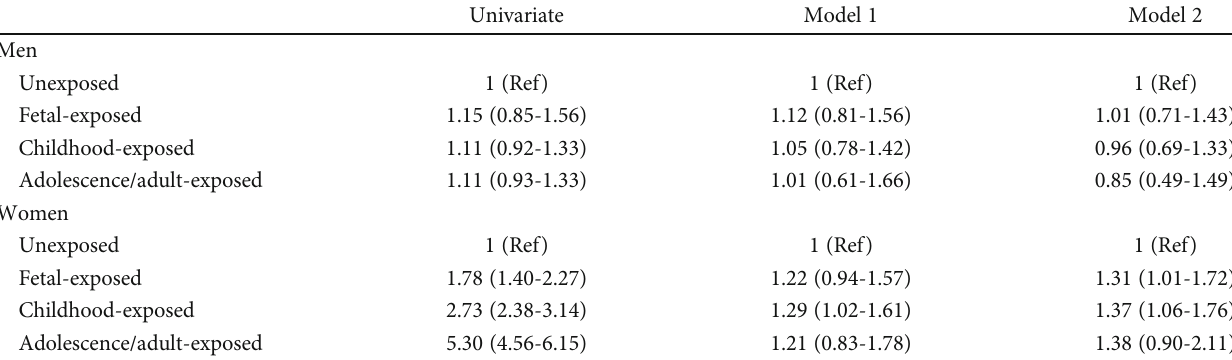
Table 6: Odds ratio (95% con fi dence interval) of metabolic syndrome in relation to di ff erent life stages at famine exposure by the IDF de fi